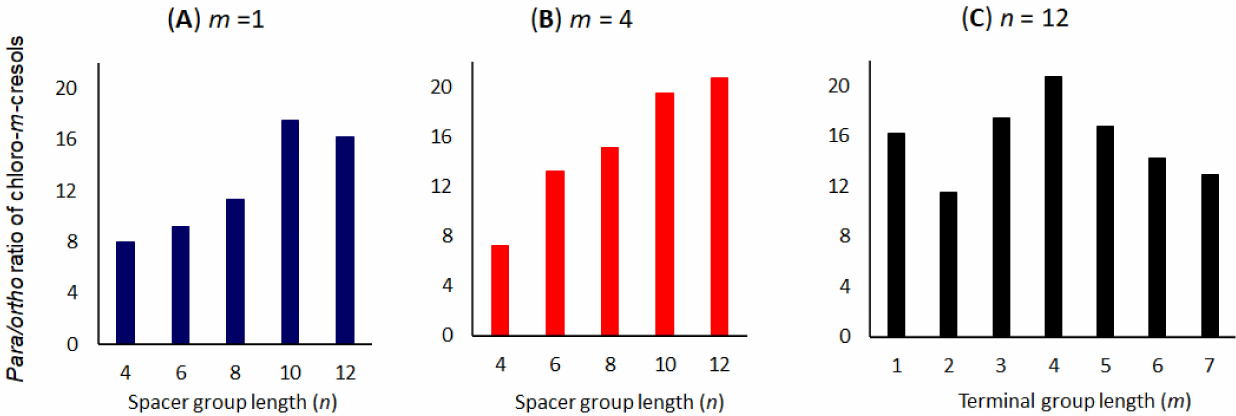
Figure 5. Effect of variation of terminal and spacer group length of dithiaalkanes 10 [(H(CH 2 ) m S(CH 2 ) n S(CH 2 ) m H] on the selectivity of chlorination of m- cresol ( 1 , R = 3-Me) according to Scheme 1. Conditions: m- cresol (100 mmol), SO 2 Cl 2 (110 mmol), dithiaalkane (2.7 mmol), AlCl 3 (3.8 mmol), 20 ◦ C, 4 h. The ortho- product 2 (R = 3-Me) is a mixture of 2-chloro-3- methylphenol (minor) and 6-chloro-3-methylphenol (major). Some of the results have not been previously published [62]. ( A ) Terminal groups are Me; spacer length varied; ( B ) Terminal groups are n- Bu; spacer length varied; ( C ) Spacer group is twelve CH 2 groups long; terminal group length